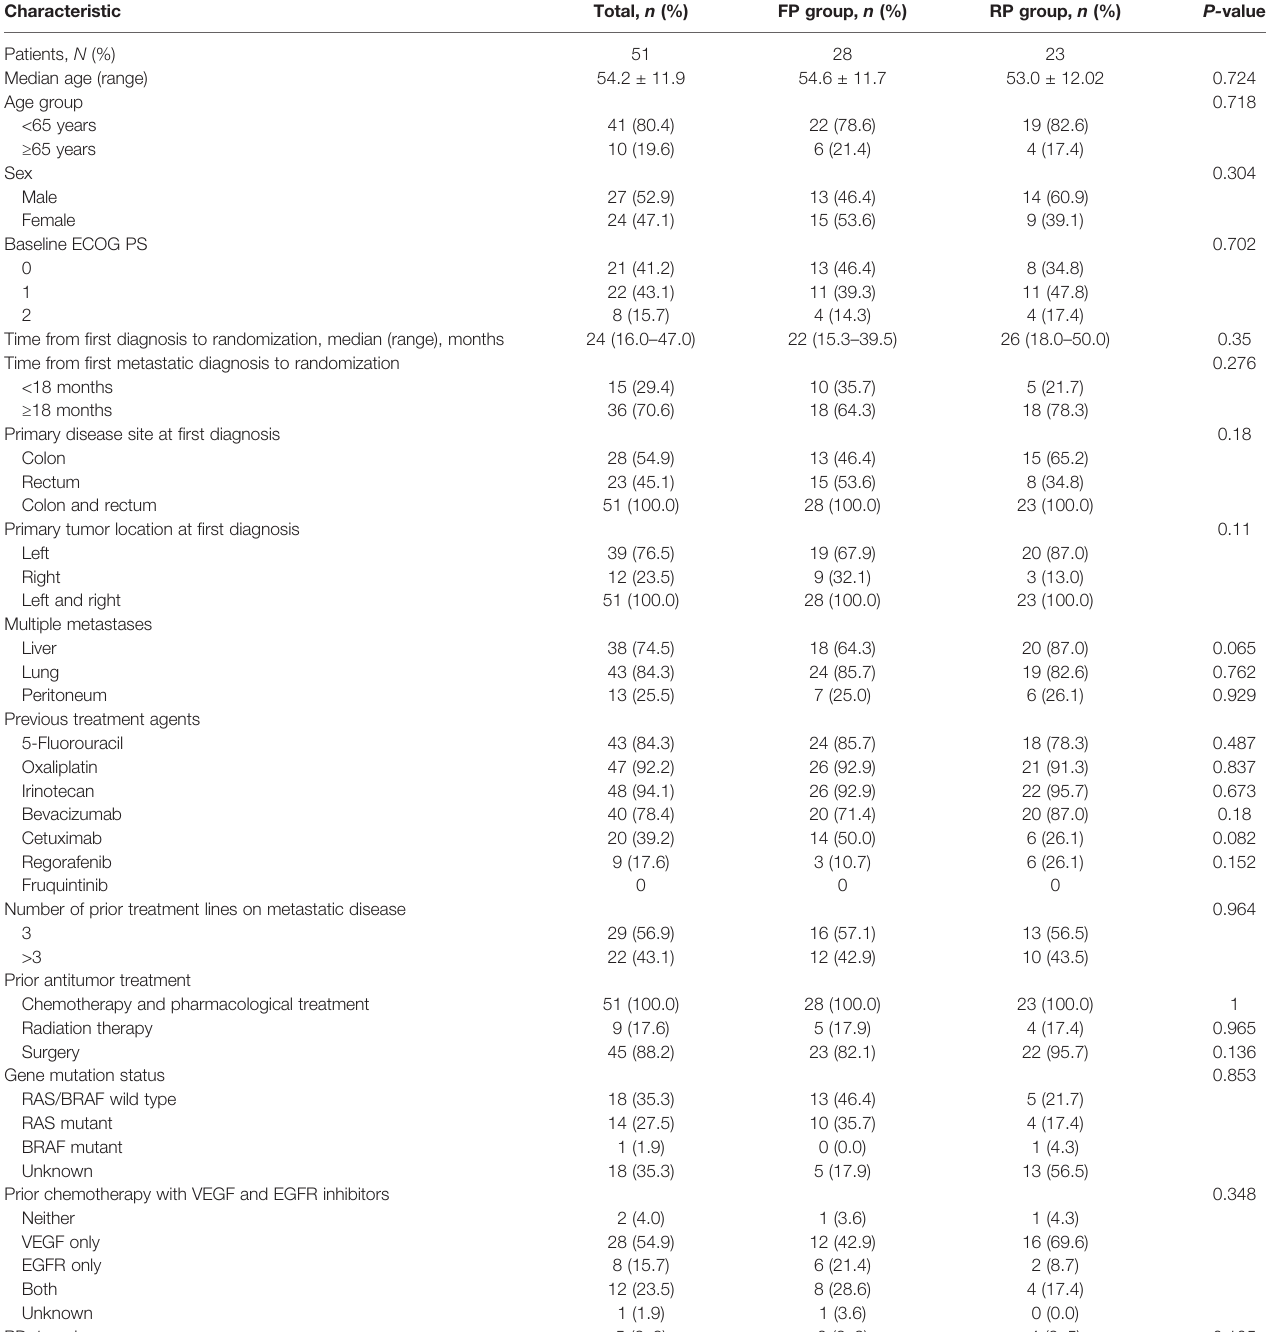
TABLE 1 | Baseline clinical characteristics of